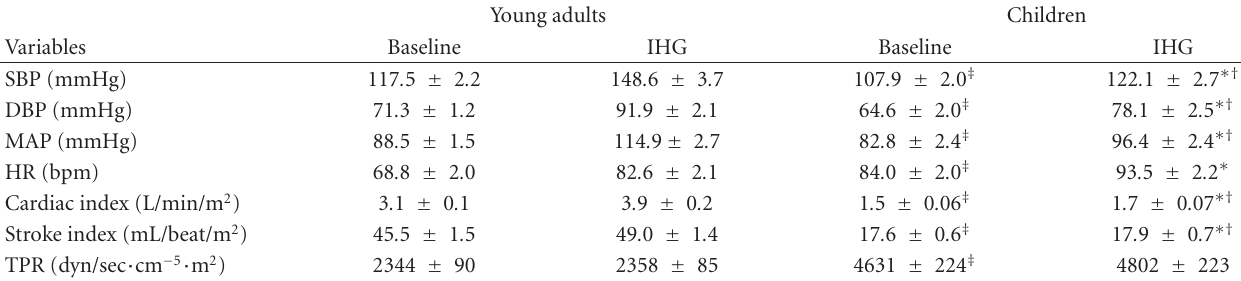
Table 2: Hemodynamic variables (unadjusted means) at baseline and in response to handgrip